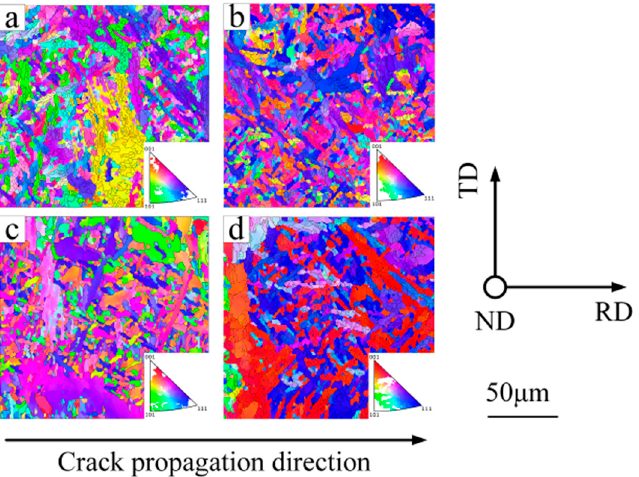
Figure 10. IPF diagrams in X80 steel welded joints. ( a ) In air and ∆ K equals to 45 MPa·m 1/2 ; ( b ) in air and ∆ K equals to 60 MPa·m 1/2 ; ( c ) in water and ∆ K equals to 45 MPa·m 1/2 ; ( d ) in water and ∆ K equals to 60 MPa·m 1/2 .